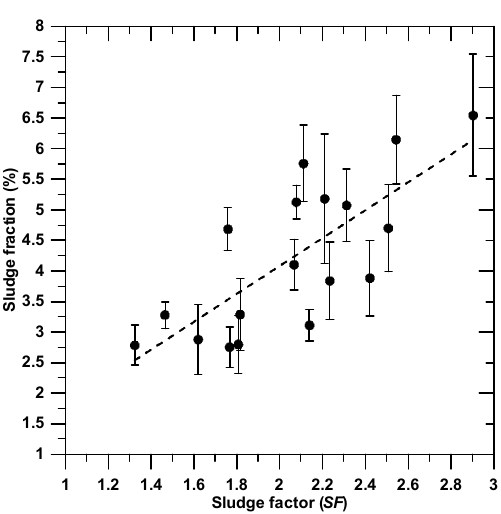
Figure 6. Sludge area fraction as function of sludge factor, SF.